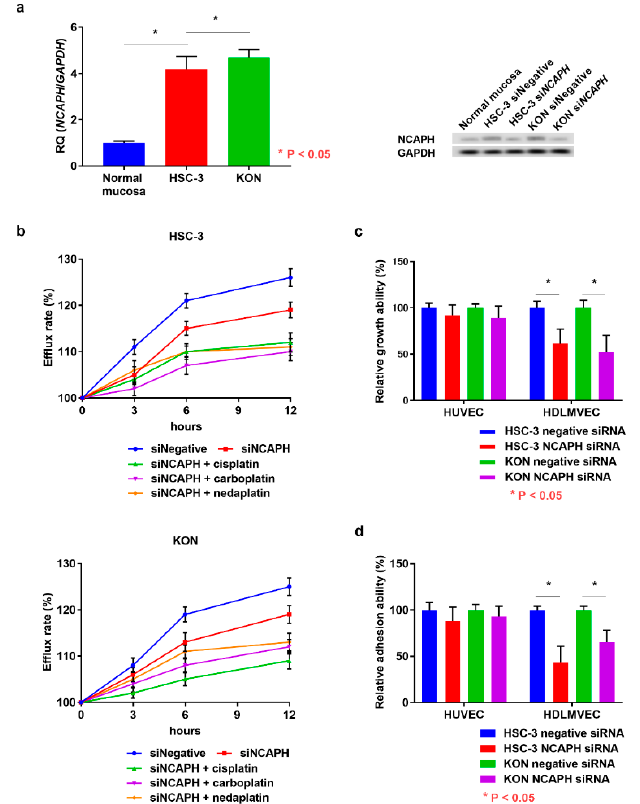
Figure 3. Functional analysis of NCAPH in OSCC cells. ( a ) Change in NCAPH expression in OSCC cells following treatment with NCAPH siRNA and negative control siRNA. ( b ) Influence of NCAPH siRNA treatment on anticancer drug resistance and the e ff ects of cotreatment with NCAPH siRNA and cisplatin, carboplatin, or nedaplatin in OSCC cells. E ff ects of NCAPH silencing on the adhesion ( b ) and transmigration ( c ) of endothelial cells to OSCC cells. Error bar, standard deviation (SD). RQ; relative